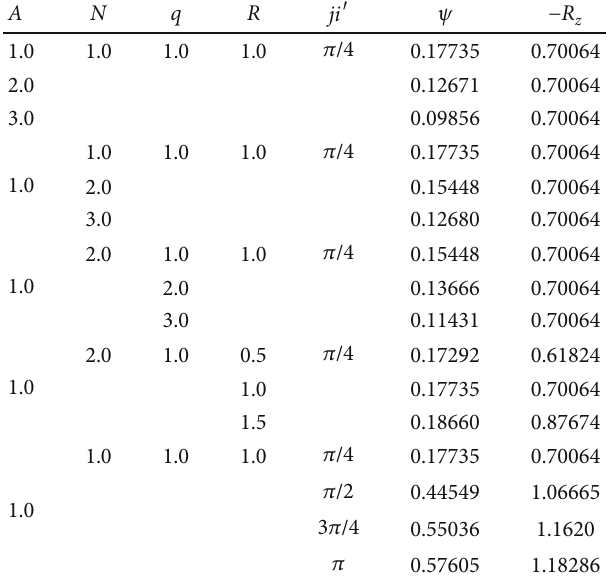
for various values of A , N , q , z = 1 : 0 , and ε = 0 : 1 g